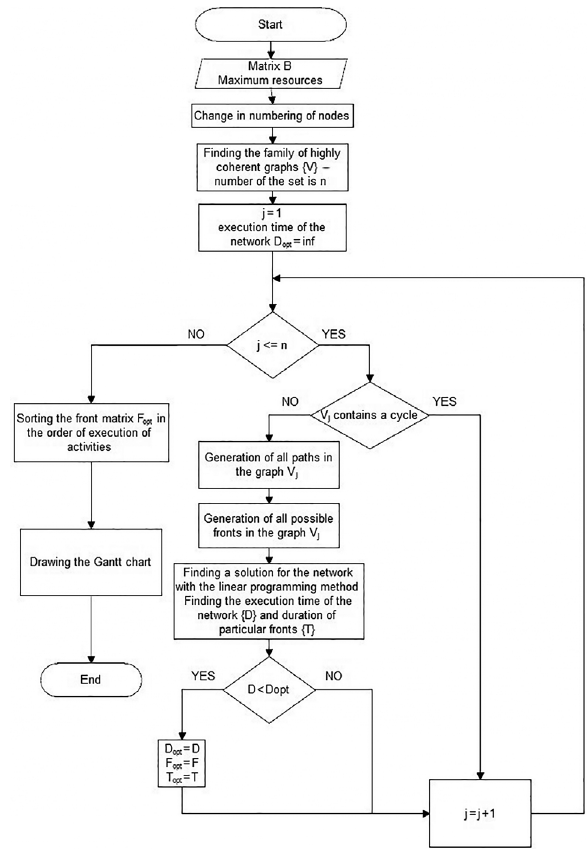
Fig. 1. The FROPT